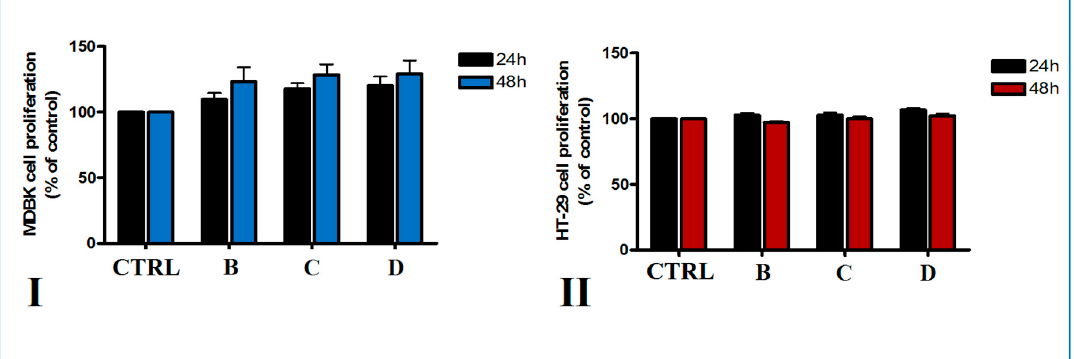
Figure 9. In vitro viability of MDBK ( I ) and HT-29 ( II ) cells grown in direct contact for 24 and 48 h with biopolymer-modified clays (B-PMAA-Cl 93A, C-PMAA-Cl 93A-C8, D-PMAA-Cl 93A-C18). Cell viability was expressed as percent of control (untreated cells) ± SD of three different samples.